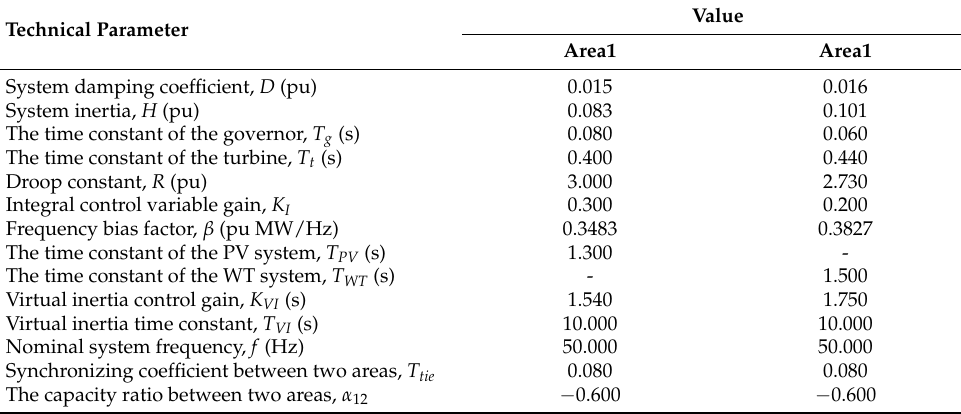
Figure 2. The dynamic model of the studied interconnected two ‐ area power system considering a VIC ‐ based BESS. Table 1. Parameters of the two ‐ area interconnected system.